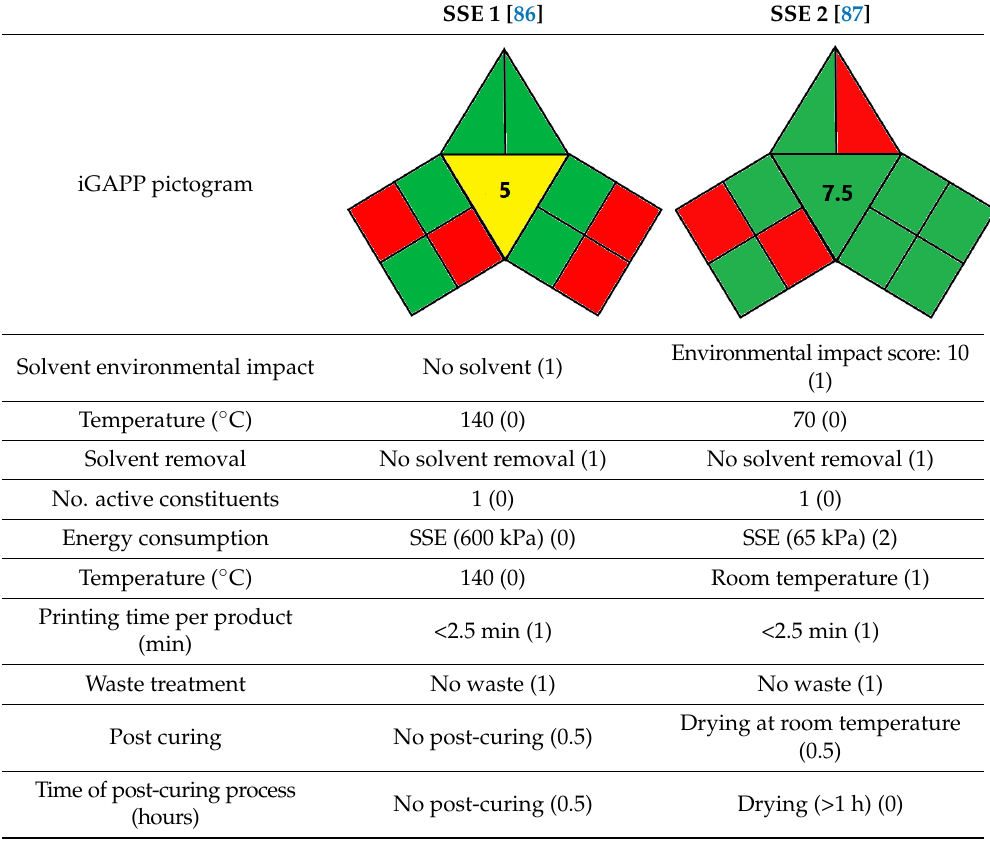
Table 5. Comparative greenness evaluation of two reported SSE methods.